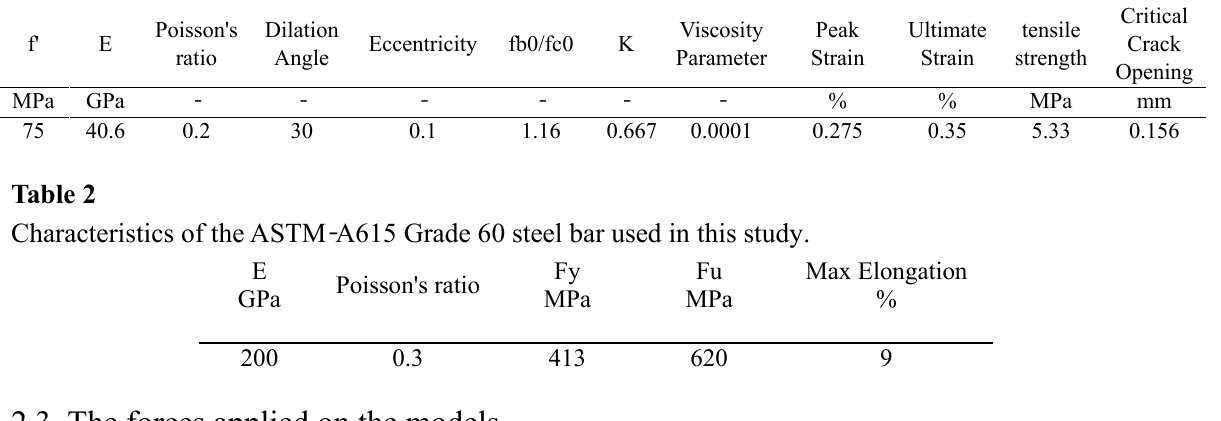
Characteristics of the C75concrete used in this study.